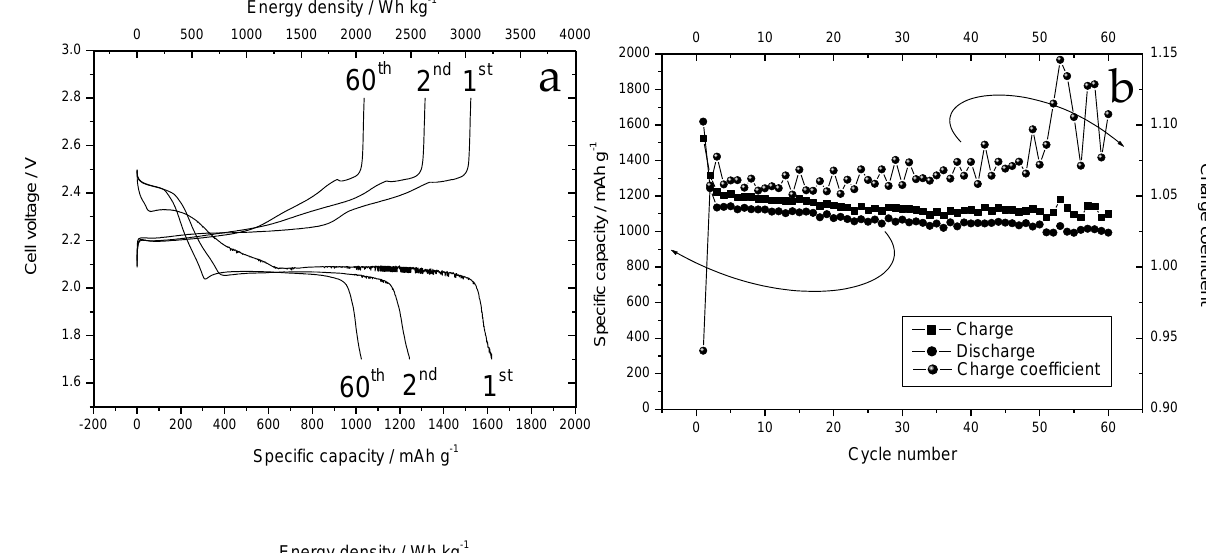
Figure 10 shows the voltage profiles (Figure 10a,c) and the variation of the specific capacity (Figure 10b,d) as a function of the number of cycles for the walnut shell and cherry stone, respectively when used as cathodes in Li-S batteries.